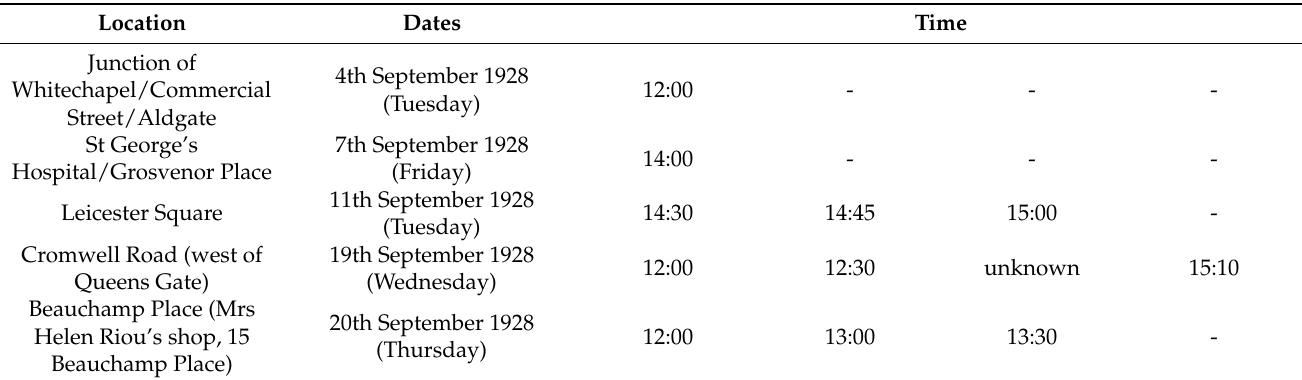
Table 1. LSN Recordings locations and